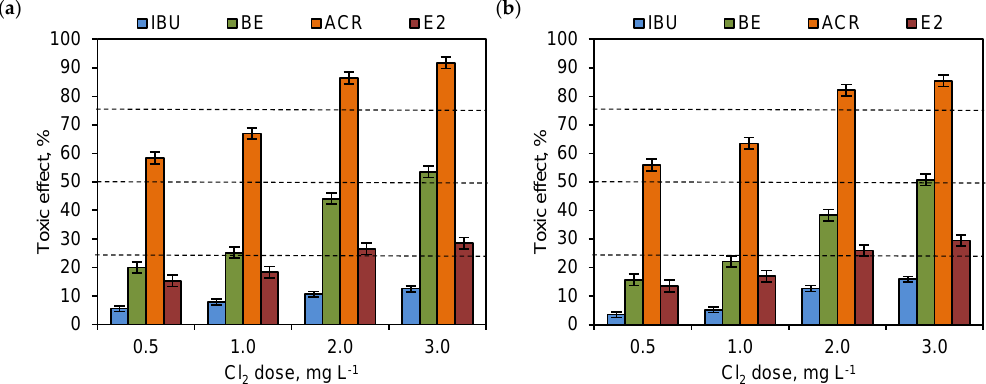
( b ) Figure 9. Change in the toxicity of chlorinated ( a ) deionized and ( b ) surface water samples without